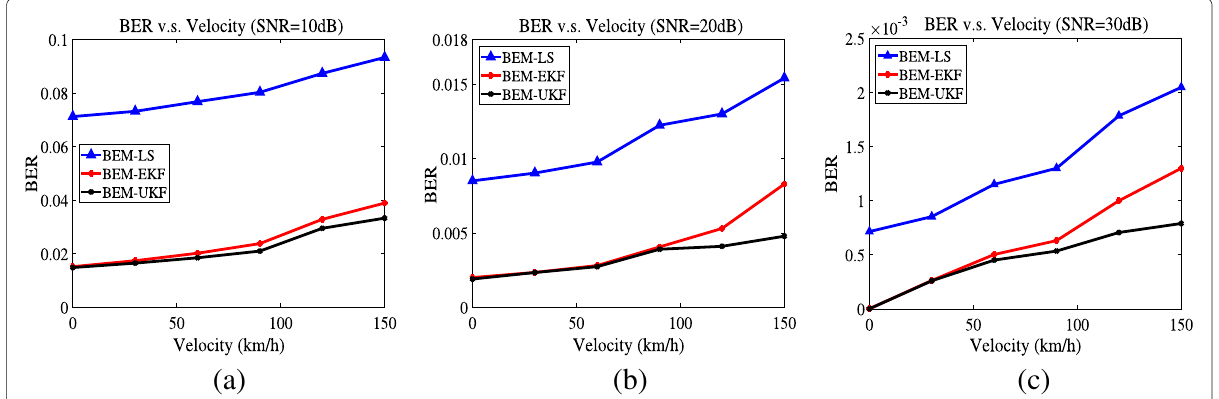
Fig. 4 BER for channel estimation methods in V2V environments with different velocities. BEM-EKF and BEM-UKF are still in a very low level compared with BEM-LS, and with the rising of velocity, BER performance for BEM-LS increases